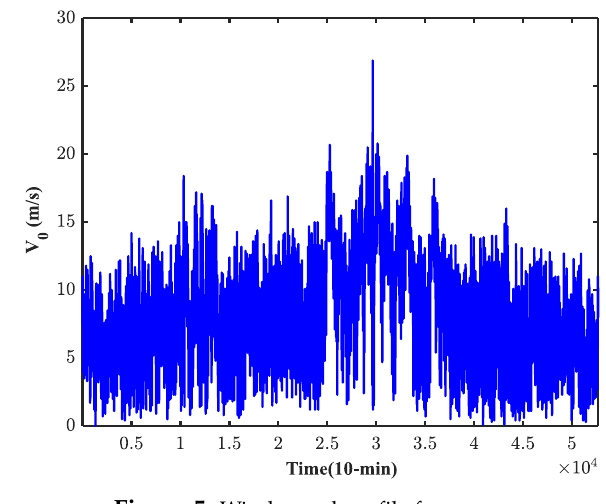
Figure 5. Wind speed profile for a year.